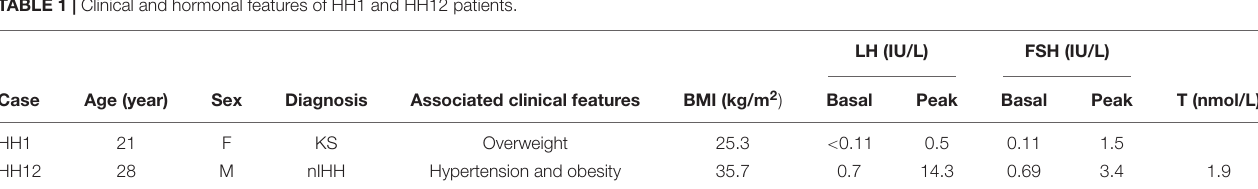
TABLE 1 | Clinical and hormonal features of HH1 and HH12